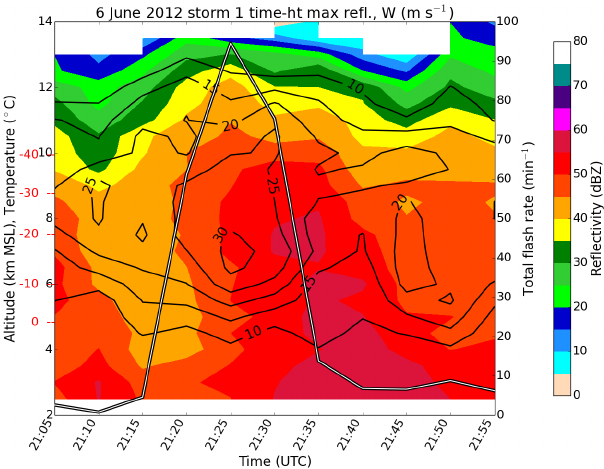
Figure 1. Time-height plot of maximum radar reflectivity (dBZ; colored contours with color scale at right) derived from CSU- CHILL radar observations and dual-Doppler-derived maximum up- draft (ms − 1 ; black contours) for the 6 June 2012 southern cell. A time series of total lightning flash rate for this storm is superim- posed (white line outlined in black). Altitude and temperatures (red text) derived from a proximity sounding are on the left-hand vertical axis; the flash rate scale is on the right-hand vertical